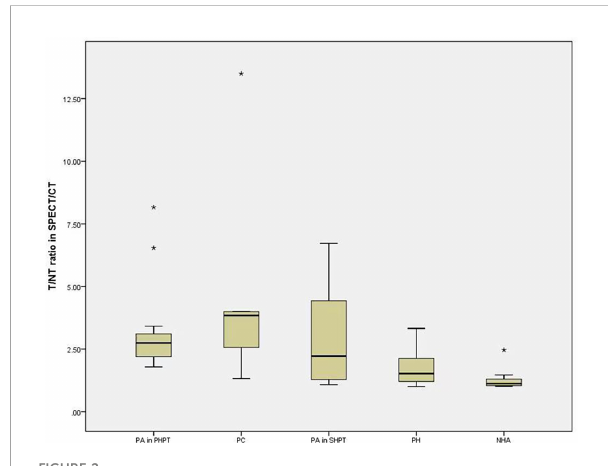
subgroups. Boxplots indicate median value (black), fi rst and third quartile range (box). Pairwise comparison by independent sample Kruskal-Wallis test, there was statistical signi fi cance between NHA and PA in PHPT (P=0.004). There was statistical difference between NHA and PTC (P=0.14). T/NT, target-to-non-target. PA in PHPT, parathyroid adenomas in primary hyperparathyroidism; PC,